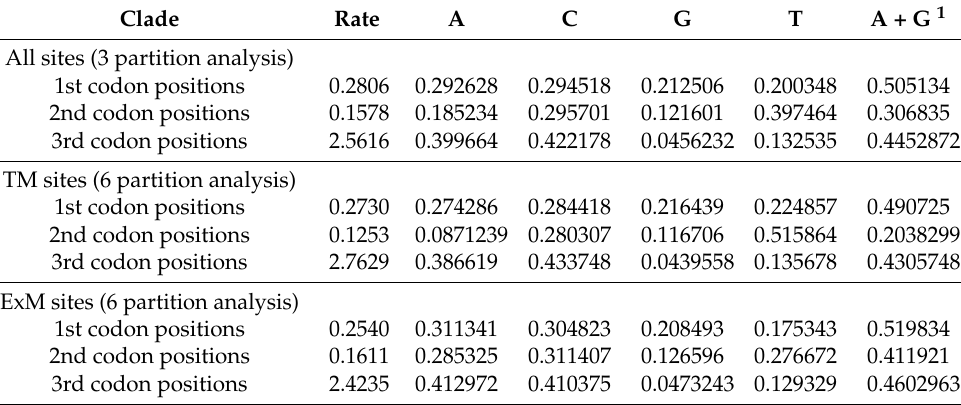
Table 5. ML estimates of base frequencies and relative partition rates in the analyses of nucleotide sequences. Clade Rate A C G T A + G